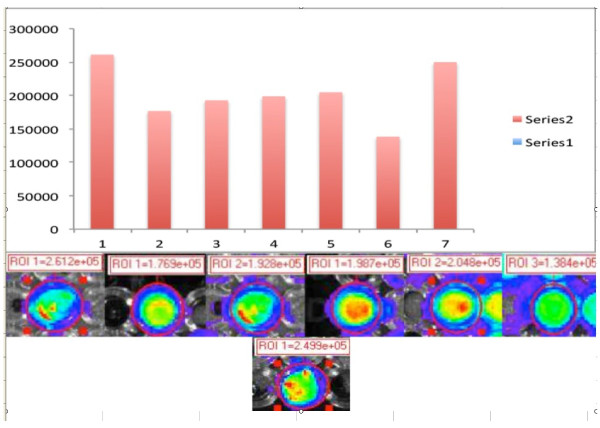
Seven independent DLD1/SV-rLuc/ELec clones were selected after seeding of 10 cells/ml in 96-well plates and treated with coelenterazine 25 μg/ml after overnight incubation. Output (p/sec/cm2/sr) was immediately quantified using IVIS machine.